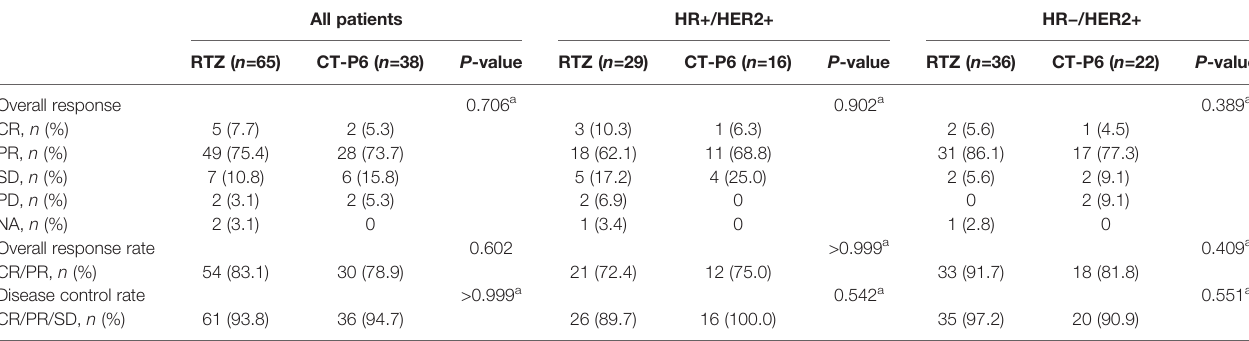
TABLE 2 | Best overall response, based on RECIST 1.1 criteria, according to palliative treatment in patients with HER2-positive metastatic breast cancer. All patients